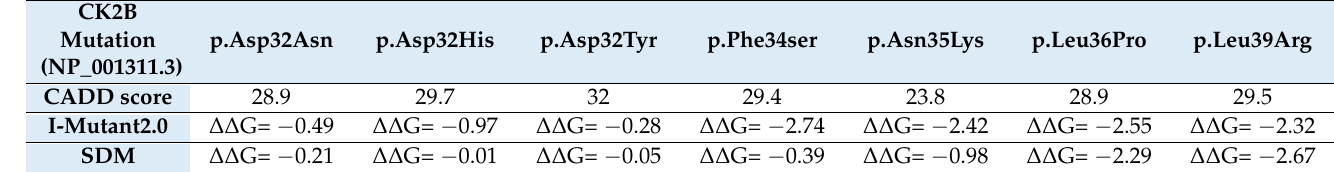
Table 1. Prediction tools were used to interpret the possible deleterious effect of CK2beta mutations affecting the KEN box-like motif. I-Mutant2.0 and SDM were used to predict protein stability upon the mutation; they provide the folding free energy and the stability difference score ( ∆∆ G). A ∆∆ G ≥ 0.0 corresponds to mutations predicted to be stabilizing, whereas ∆∆ G <0.0 corresponds to mutations predicted to be